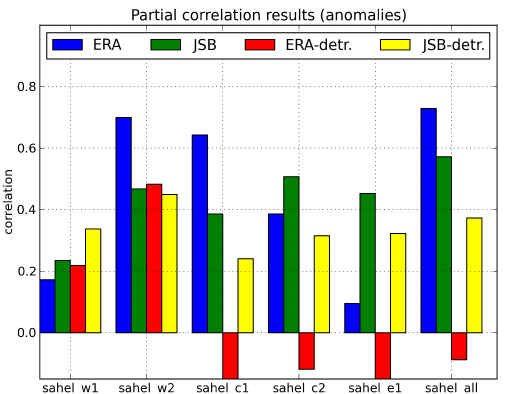
Fig. 12. Partial correlation coefficients between ERA-interim and JSBACH soil moisture and ECVSM with prior removal of precipitation influence on the correlation coefficient.